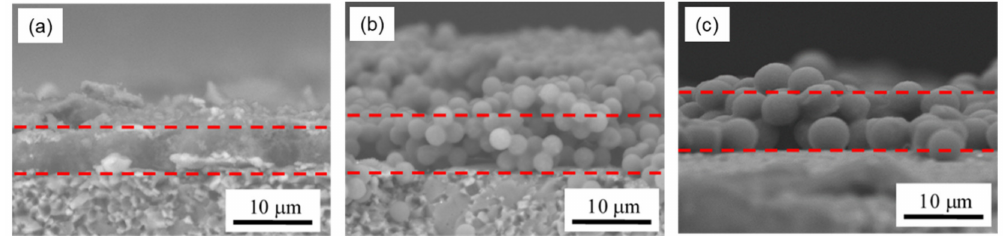
Figure 5. SEM images of cross sections of sensors: ( a ) deposited film, ( b ) PSt@PANI(2.5) film, and ( c ) PSt@PANI(4.5)